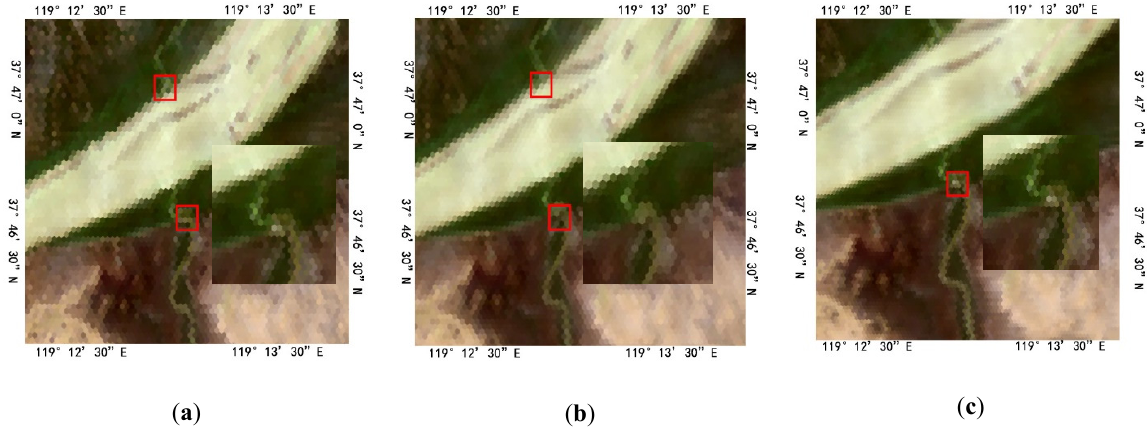
Figure 10 . Hexagonal grid images converted from Landsat 8 images in the same area using different resampling methods. ( a ) Generated by nearest-neighbor interpolation; ( b ) generated by bilinear interpolation; ( c ) generated by bicubic interpolation.